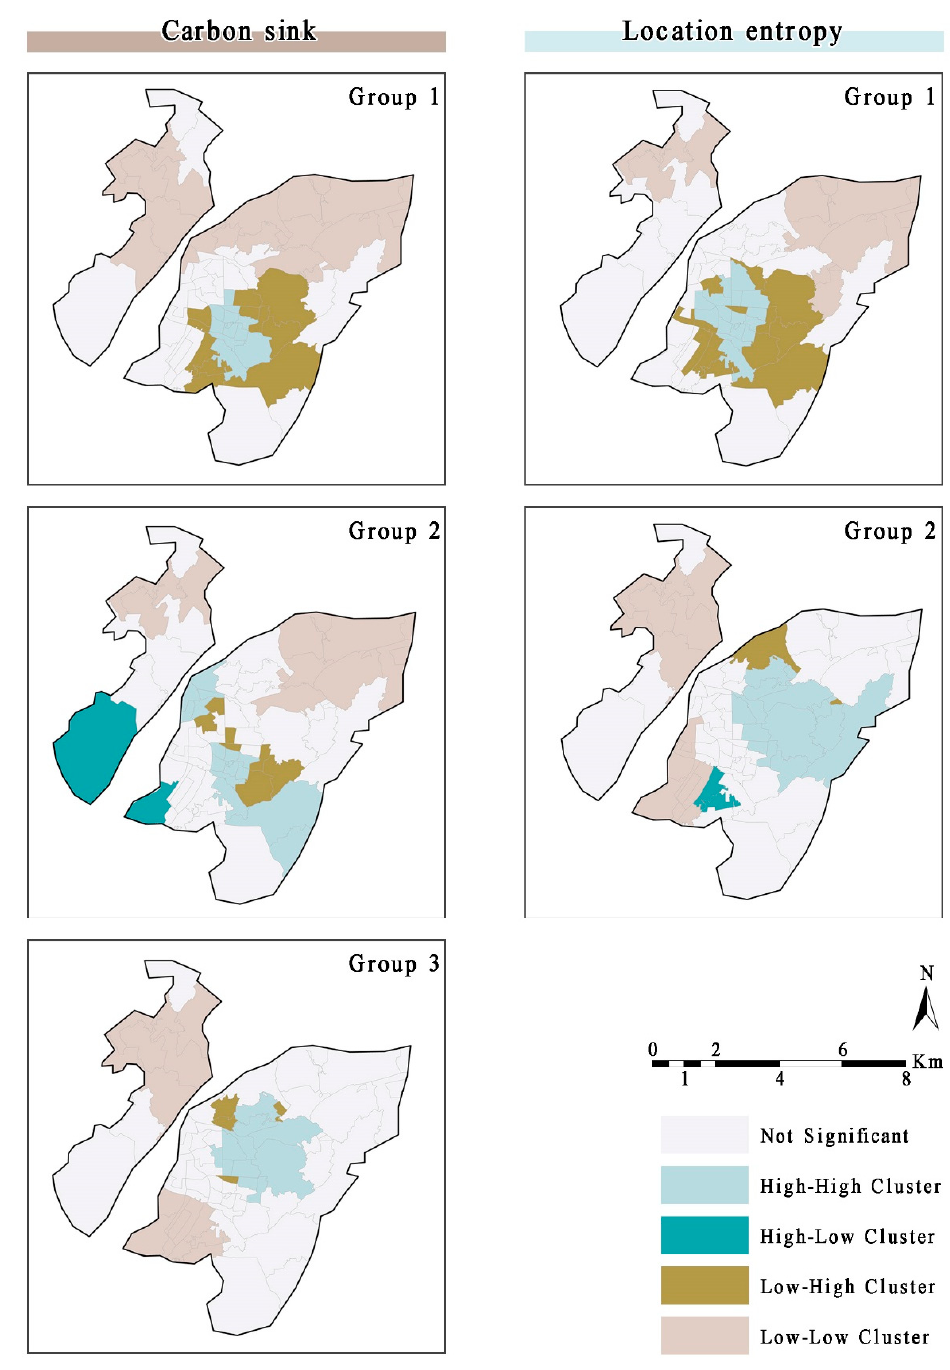
Figure 4. LISA of carbon sink performance of aggregated green infrastructure.